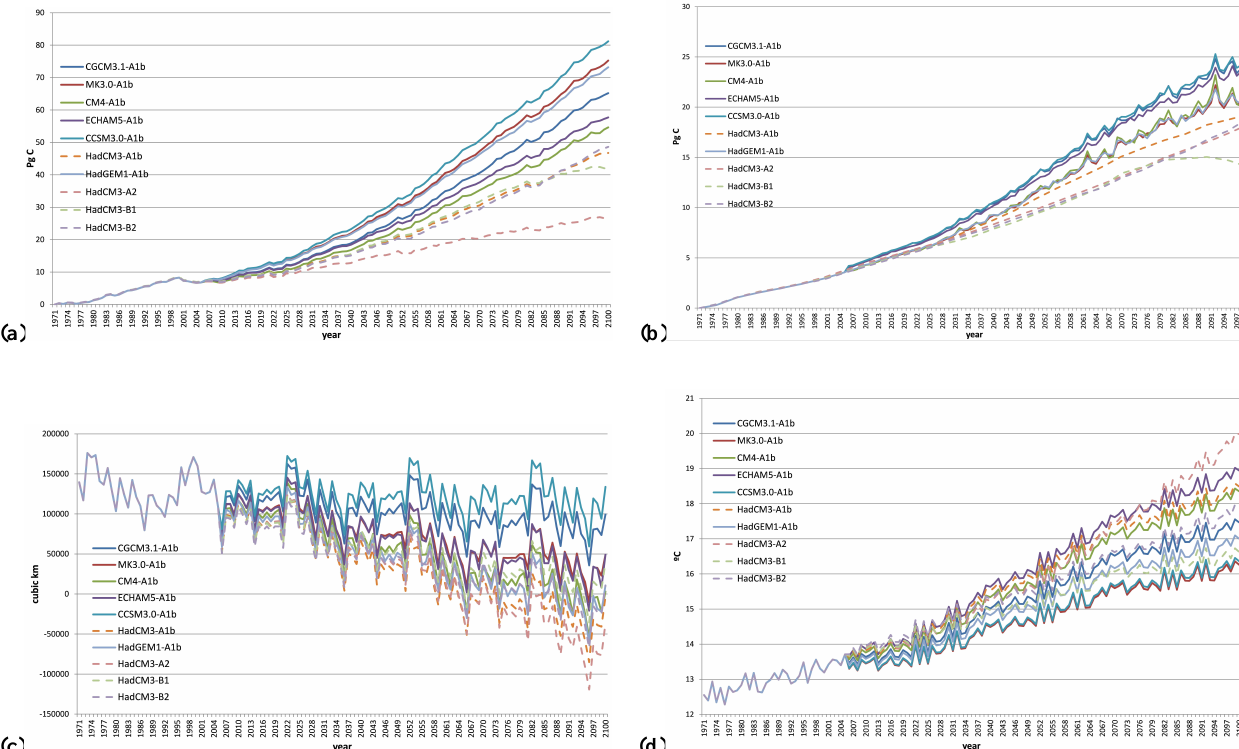
Fig. 4. (a) Total global changes in mineral SOC for ten climate scenarios, (b) changes in global plant inputs for ten climate scenarios, (c) changes in the global climatic water balance (i.e. precipitation minus evapotranspiration), (d) global mean surface temperature. All panels show results only from simulated land cells for which consistent data were available and which have a SOC concentration lower than 200tha − 1